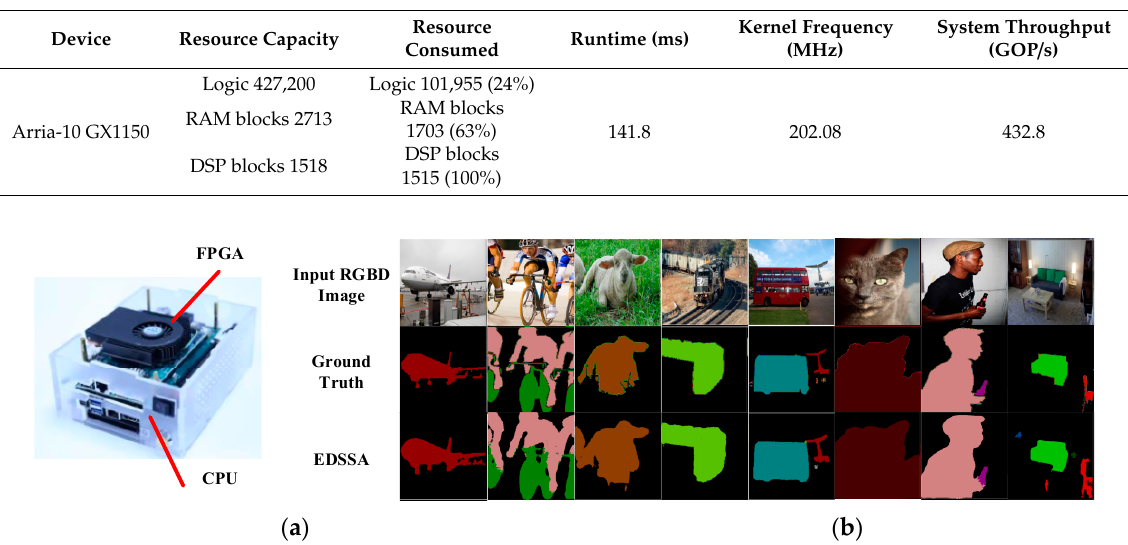
Table 2. Summary of EDSSA with best parallelism.